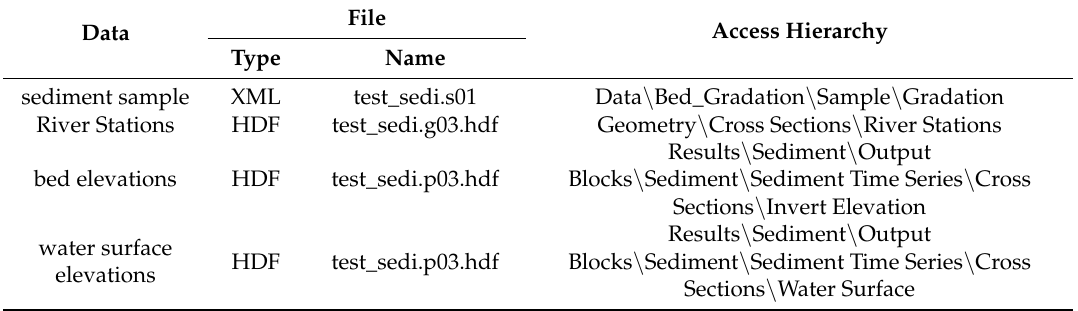
Table 1. Loading data and results from XML and HDF files: type of data, type of file, access hierarchy.